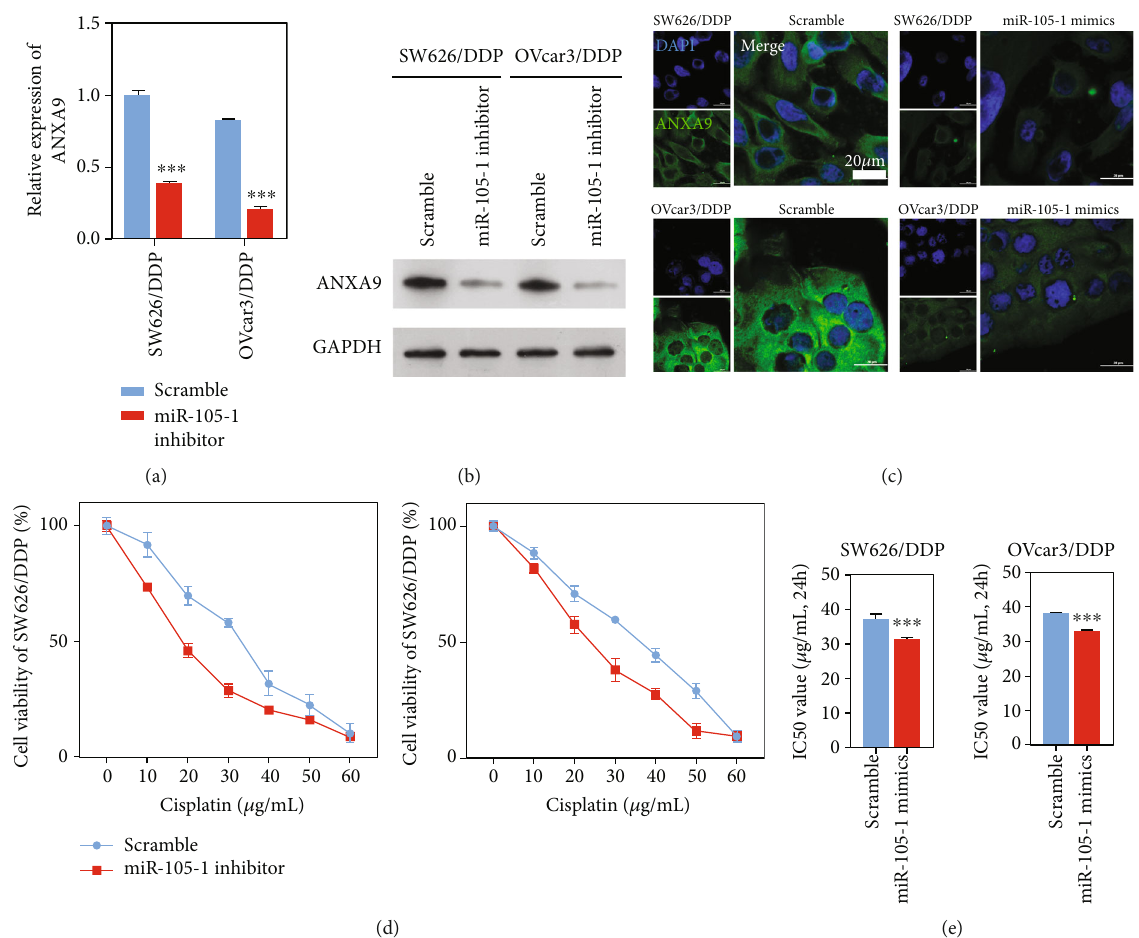
Figure 5: Upregulation of Hsa-miR-105-1 inhibited ANXA9 expression in cisplatin-resistant OC cells. SW626/DDP and OVcar3/DDP cells were transfected with the scramble or Hsa-miR-105-1 mimics. (a) The levels of ANXA9 expression as detected by qPCR assays ( n = 3 , ∗∗∗ P < 0 : 01 , and paired t -test). (b) The levels of ANXA9 protein expression as detected by western blotting. (c) The distribution of ANXA9 was shown by immuno fl uorescence. (d) The viability of scramble or Has-miR-105-1 mimic-treated SW626/DDP or OVcar3/DDP after exposure to di ff erent concentrations of cisplatin, as detected by the CCK8 assay. (e) The IC and OVcar3/DDP cells treated with the scramble or Hsa-miR-105-1 mimics in cisplatin ( n = 3 , ∗∗∗ P < 0 : 01 , and paired t